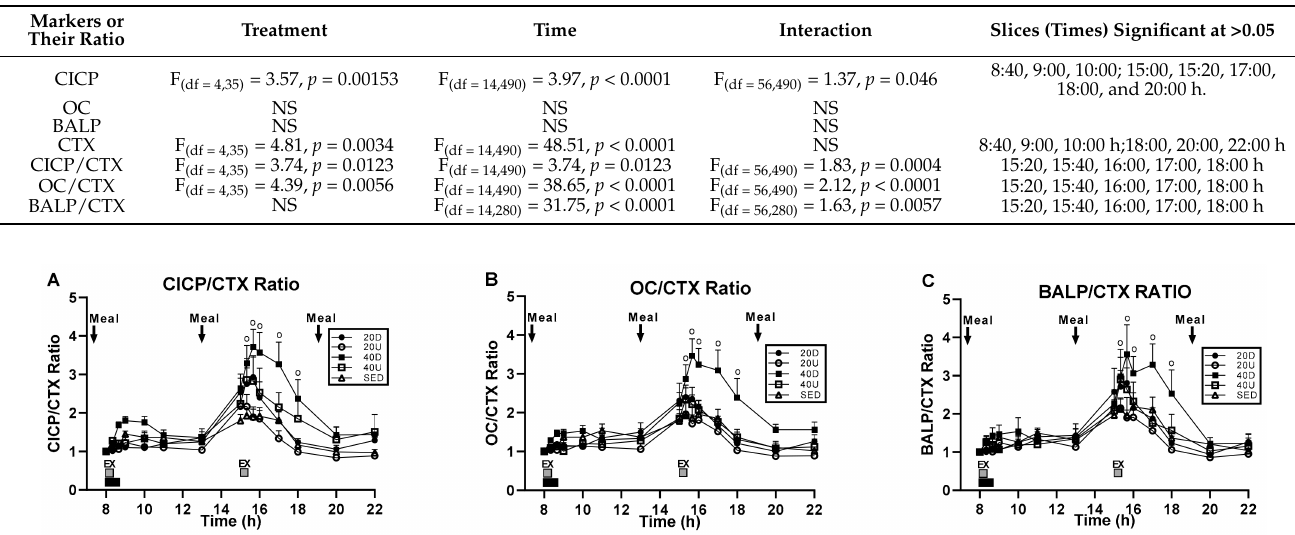
Figure 3. Time course of bone marker responses. CICP serum concentration ( A ) was significantly higher in 40 Down than in the SED group, and CTX concentration ( B ) significantly lower in 40 Down than in the 20 Up group. No changes in OC ( C ) and BALP ( D ). For CICP and CTX concentrations, “o” marks time slices of significant group differences. Table 4. Group differences resulting from timing of meals and exercise for the three markers of bone formation, the marker of bone resorption, and their ratios.